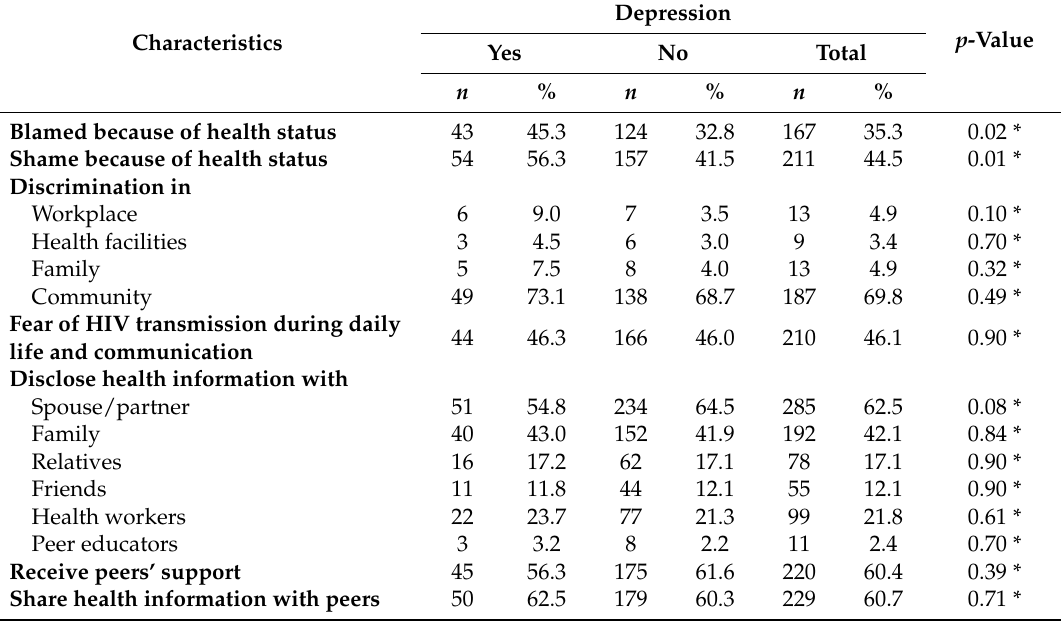
Table 5. Discrimination/stigma among patients receiving